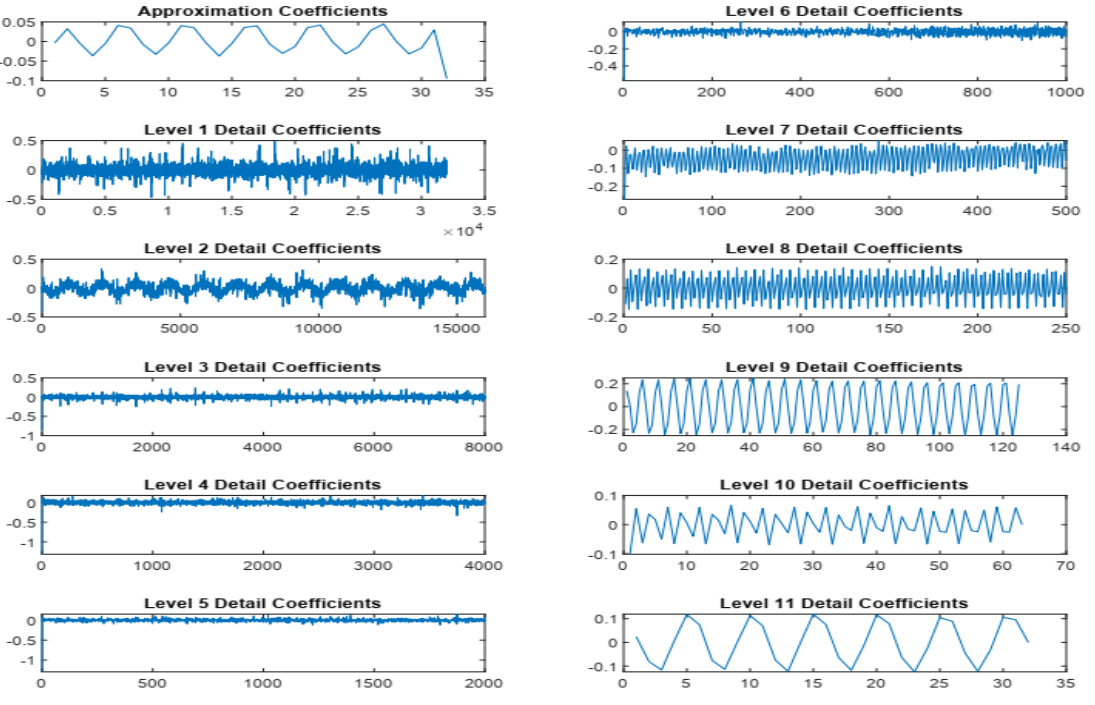
Figure 8. Wavelet decomposition of the ‘Haar’ mother wavelet of a healthy bearing.